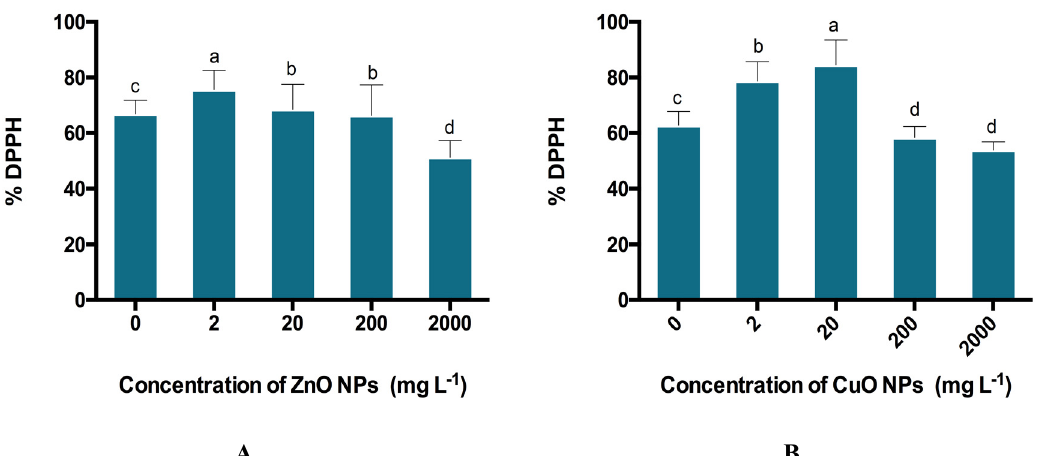
Figure 5. ( A ) E ff ect of ZnO ENPs and ( B ) e ff ect of CuO ENPs at di ff erent concentrations ranging Figure 5. ( A ) Effect of ZnO ENPs and ( B ) effect of CuO ENPs at different concentrations ranging between 0 and 2000 mg / L on % DPPH inhibition activity. Di ff erent letters indicate di ff erences according between 0 and 2000 mg/L on % DPPH inhibition activity. Different letters indicate differences to the Duncan’s multiple range test ( p < according to the Duncan´s multiple range test ( p < 0.05).